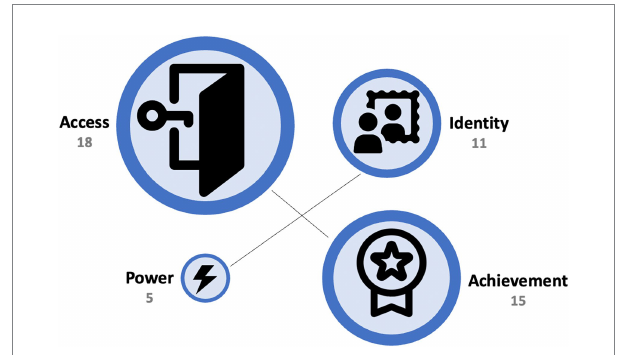
FIGURE 2 Frequency of four equity dimensions in the teachers’ conceptions of equity ( N = 23). The size and the thickness of each circle are proportional to the number of teachers who mentioned each dimension (numbers are next to the circles). Dominant axis: Access – Achievement, Critical axis: Identity –